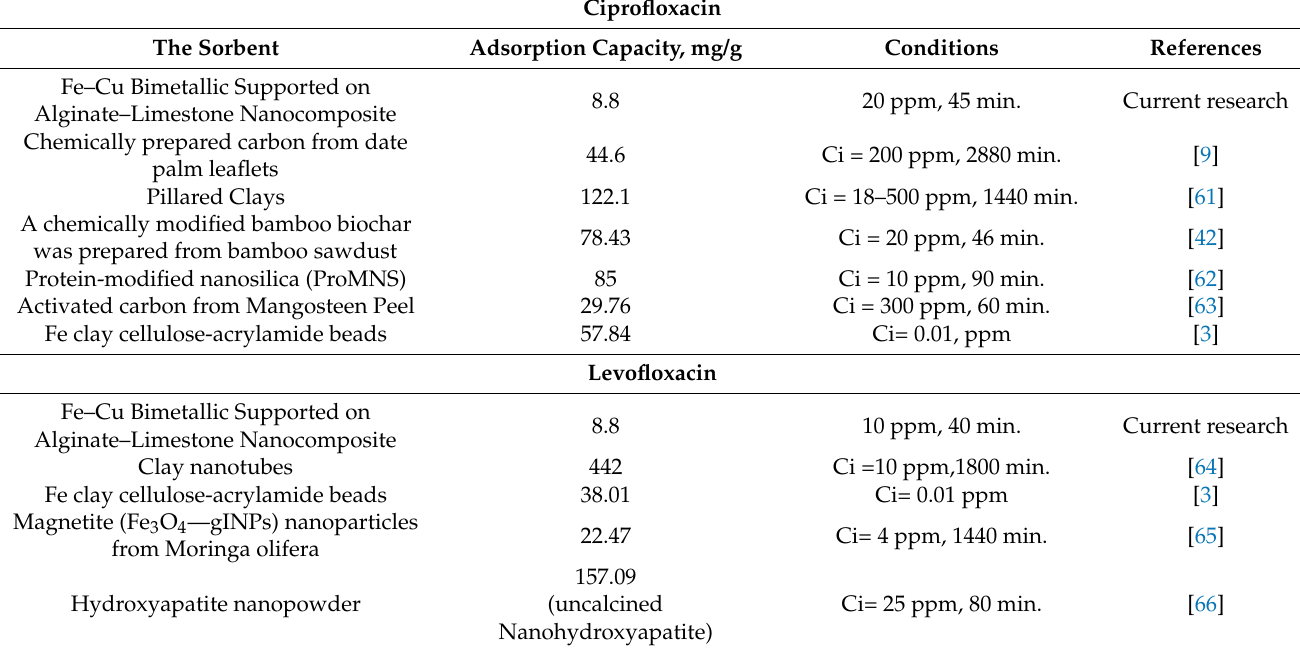
Table 6. A comparison between the sorption capacities for CIP and LEV with other sorbents in previous